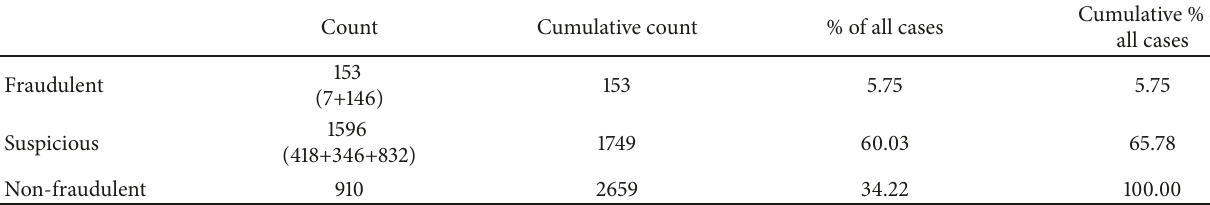
Table 2: Clusters after labeling. The values in parentheses indicate the frequency of clusters that are merged.